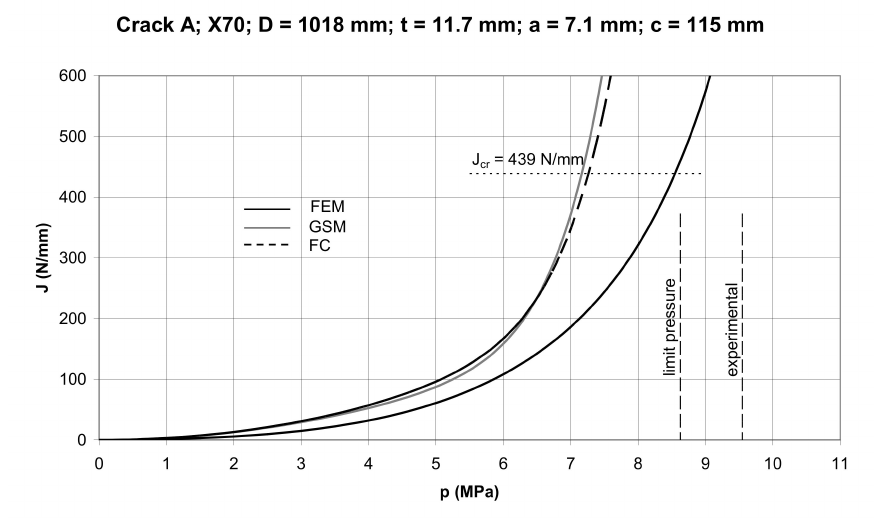
Figure 21. J–p dependences for Crack A.